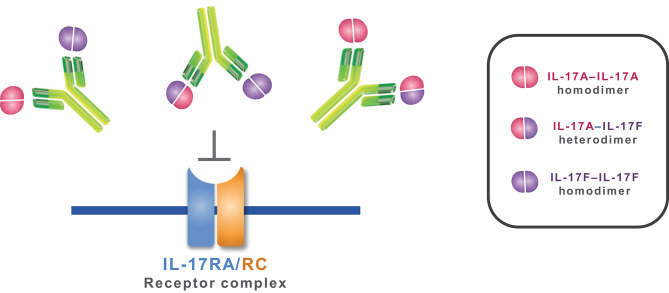
Mechanism of action of bimekizumab. By selectively binding to IL-17A, IL-17F, and the IL-17A/F heterodimer, bimekizumab inhibits the activation of the IL-17RA/RC receptor complex by these cytokines, and the subsequent inflammatory cascade.